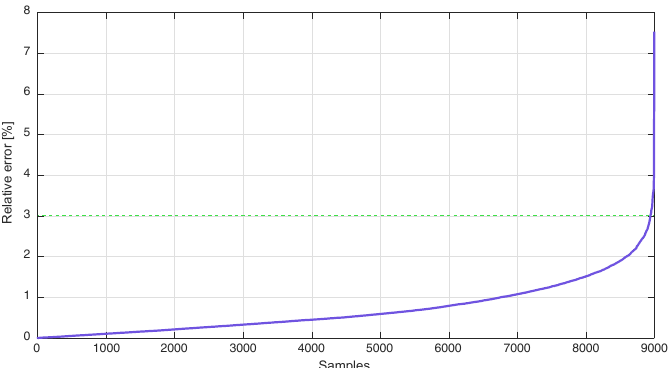
Figure 3. Real data of the first FC load current profile used to select the training samples of the SVM model.